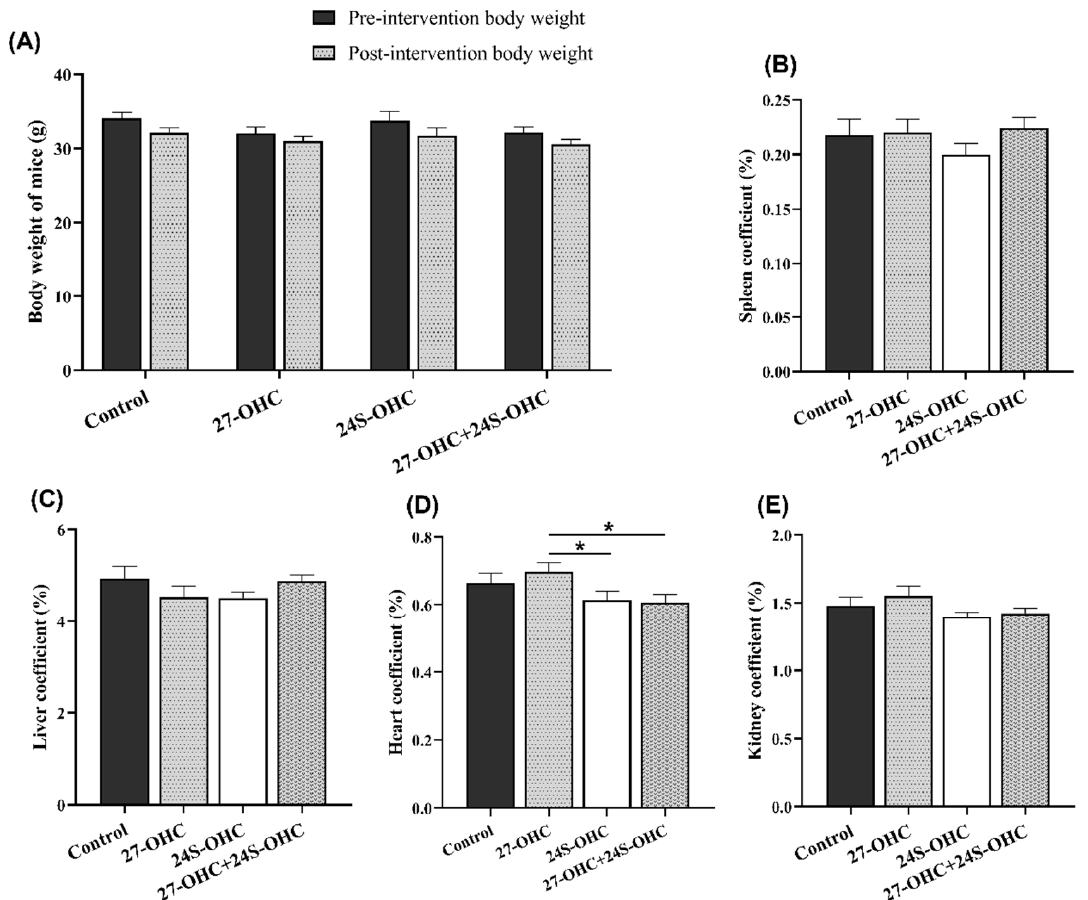
Figure 1. Effects of oxysterols on body weight and organ coefficient ( n = 10, mean ± SEM). ( A ) Body weight of mice pre- and post-intervention; ( B – E ) organ coefficient of spleen, liver, heart and kidney (organ weight/body weight, %). *: p < 0.05.